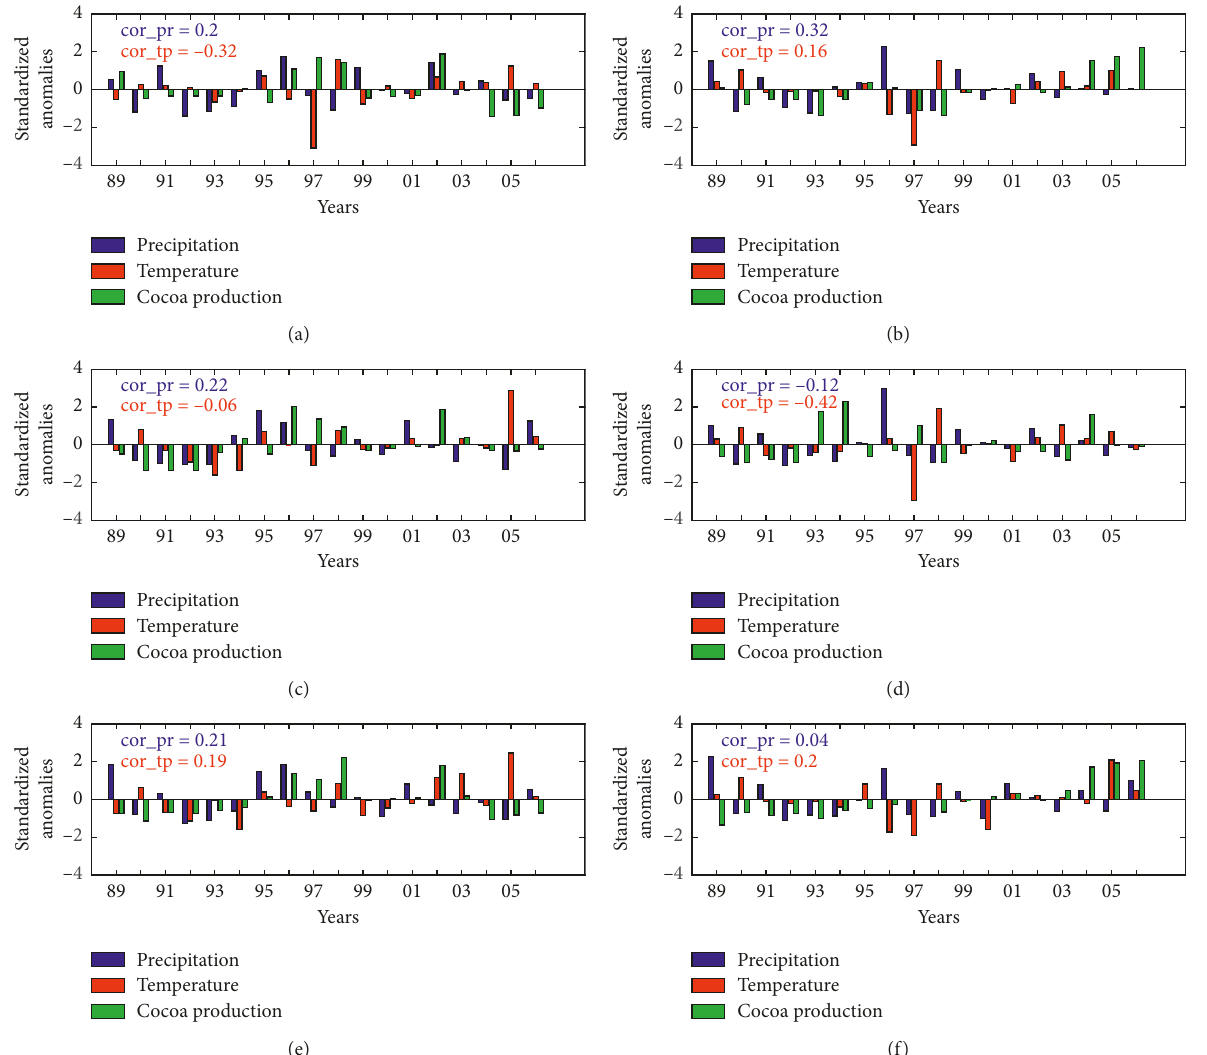
Figure 5: Standardized anomalies of rainfall of the little dry season, temperature, and cocoa production in the six departments from 1989 to 2006. The correlation coefficients between cocoa production and rainfall (blue) and temperature (red). (a) Abengourou. (b) Agboville. (c) Daloa. (d) Dimbokro. (e) Guiglo. (f)